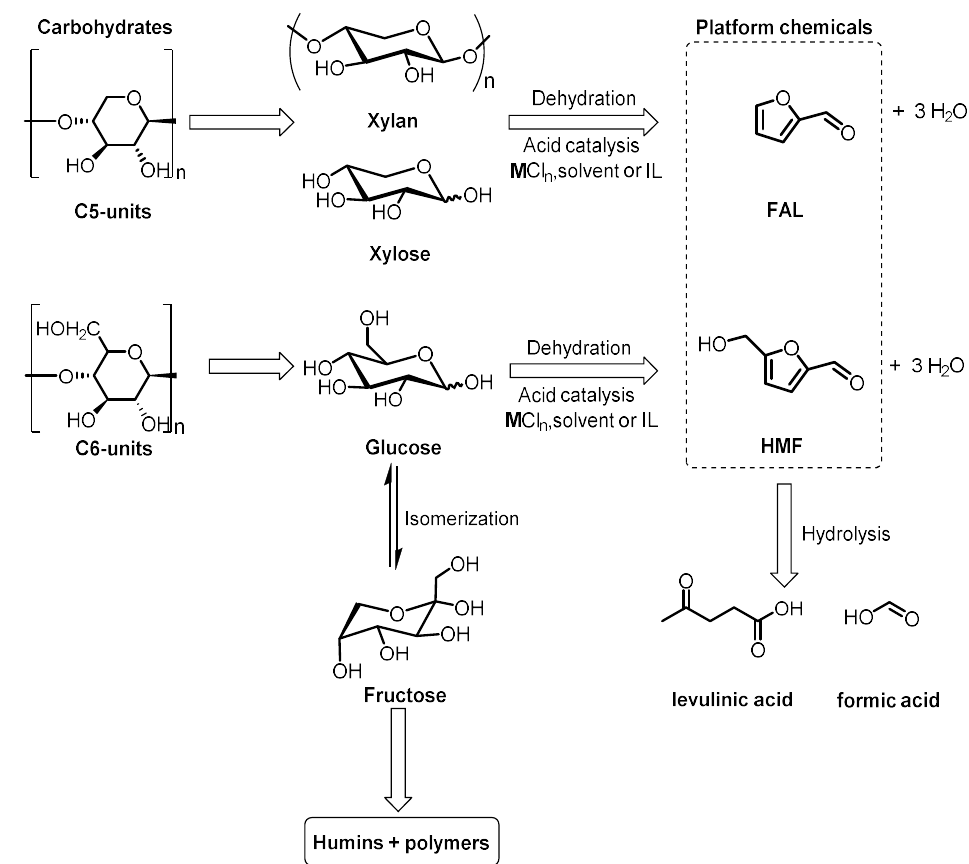
Figure 3. Upgrading of lignocellulosic polysaccharides to the primary furanics FAL and